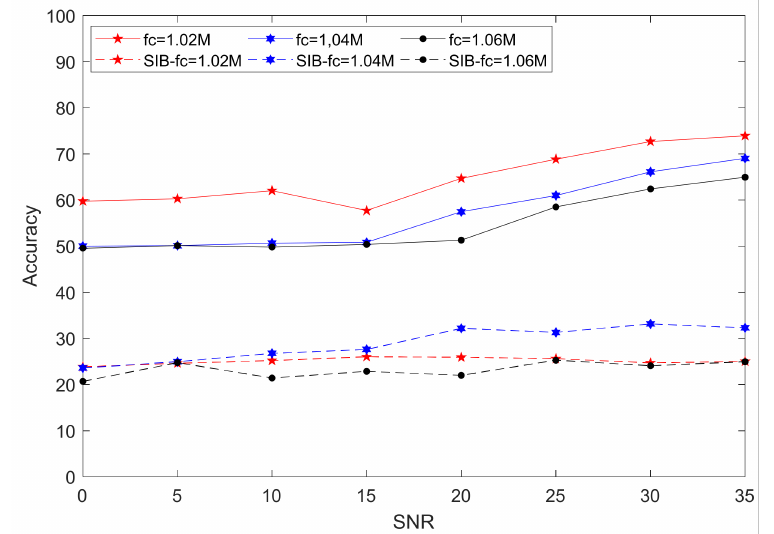
Figure 12. Relationship between recognition accuracy and SNR of the proposed method and bispec- tral method on test-set data of different carrier